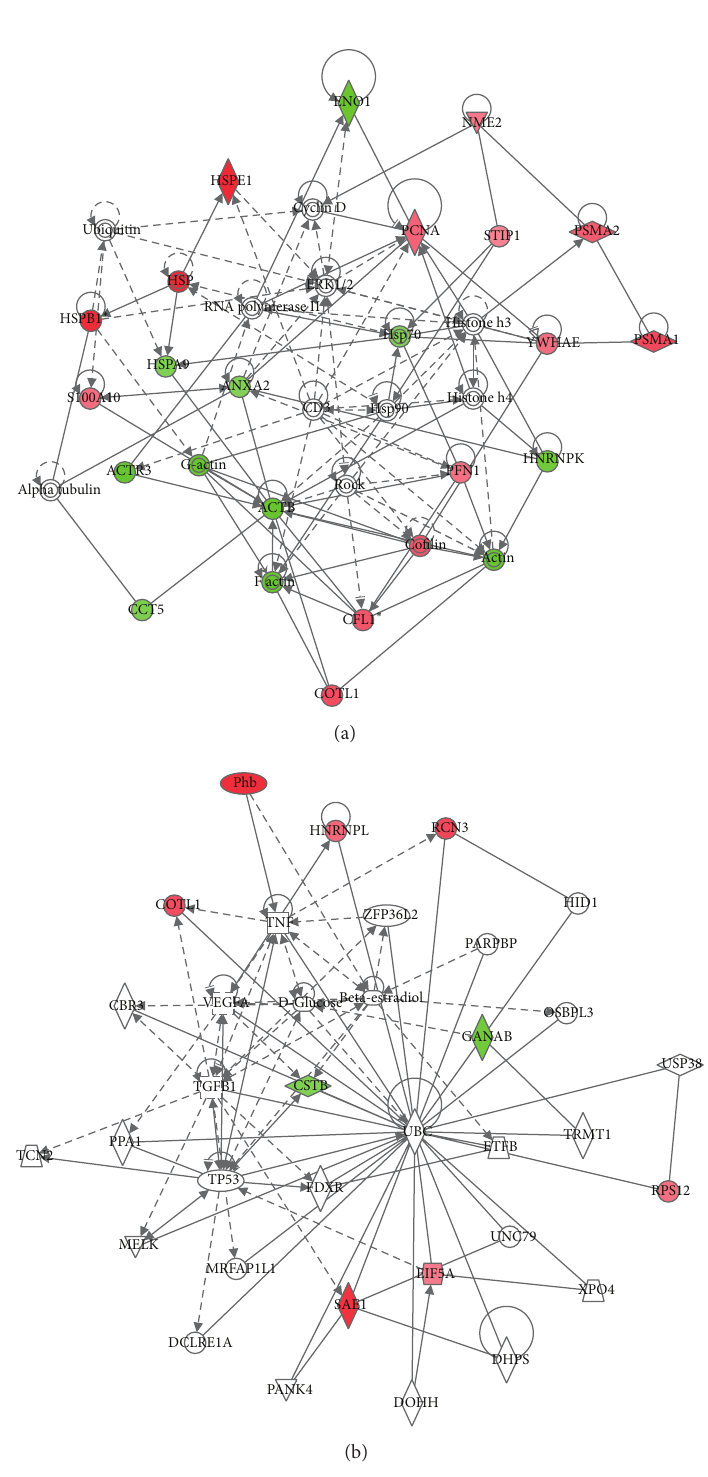
Figure 2: Network analysis of protein expression patterns using Ingenuity Pathways Analysis. (a) The top scoring network (Network 1) addressed cancer, reproductive system disease, and hematological disease and included 25 identified proteins out of 35 total network components. The score 49 suggests the odds of 1 out of 10 49 for assembling randomly these protein identifications out of the existing murine protein database. (b) Network 2, defined by IPA, includes PHB. For (a) and (b), red indicates protein spots whose spot volume increased with 2 h high glucose. Green indicates proteins spots whose spot volume decreased with 2 h high